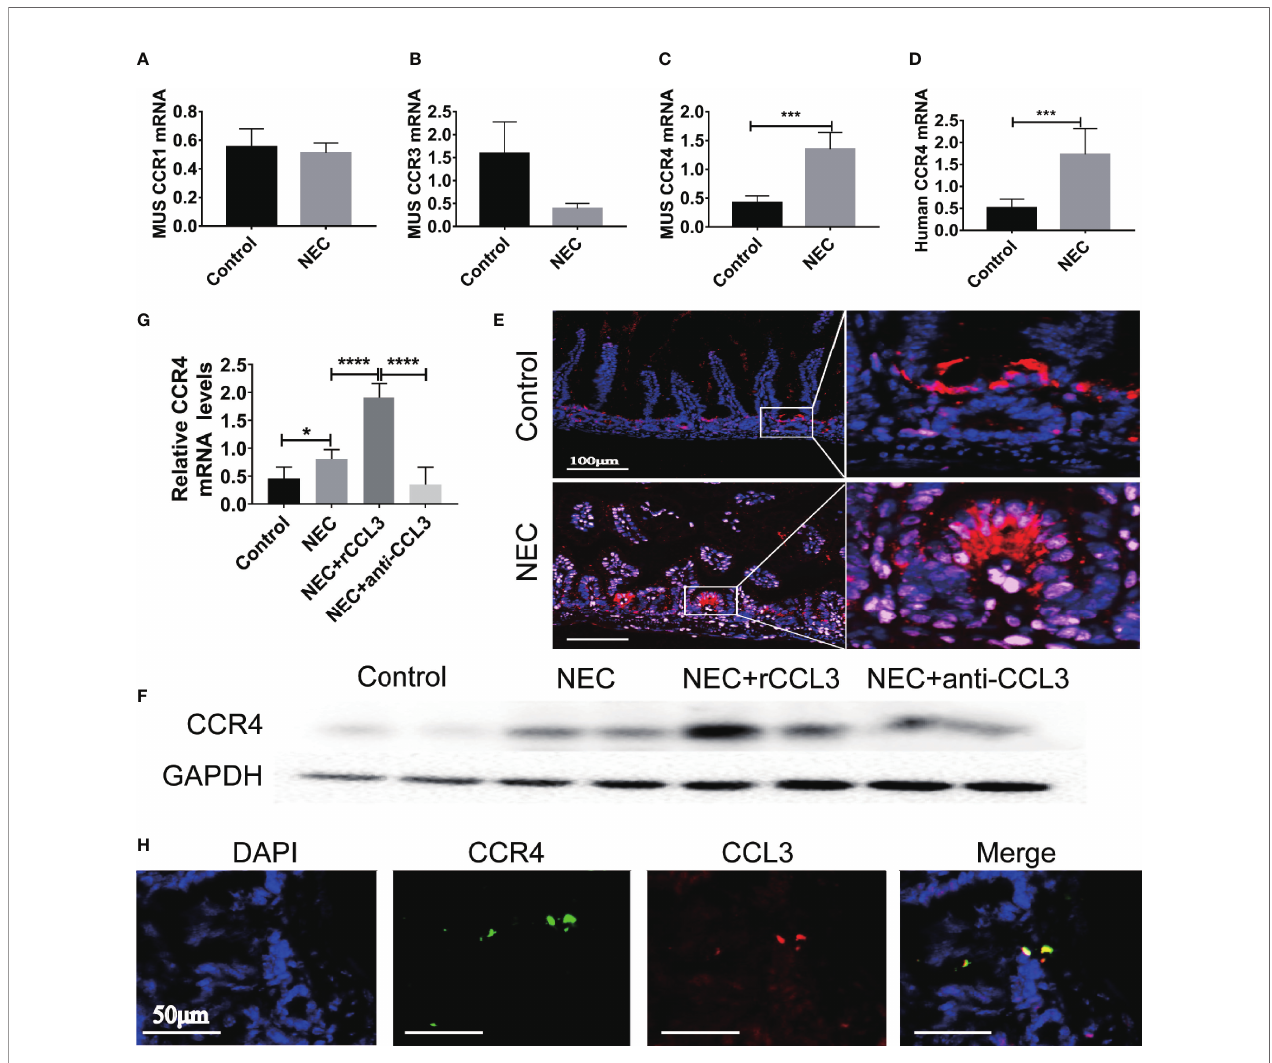
FIGURE 4 | CCL3 mediates intestinal injury by binding to CCR4 during NEC. (A-C) The mRNA expression of CCR1, CCR3, CCR4 in mice with NEC were determined by RT-PCR (n =4-6/group). ***p < 0.001 when compared with control group. (MannWhitney U test) (D) CCR4 mRNA expression in patients with NEC were detected by RT-PCR (n =4-6/group). ***p < 0.001 when compared with control group. (MannWhitney U test) (E) Representative Fluorescence micrographs from sections of the terminal ileum in mouse with or without NEC, immunostained for CCR4 (CY5-Tyramide conjugated anti-CCR4) as indicated (Scale bar=100 m m). (F, G) CCR4 in intestinal was determined by WB and the intensity was analyzed, compared with control, NEC, NEC+rCCL3 and NEC+anti- CCL3 groups. *p < 0.05, ****p < 0.0001 when compared between groups. (Mann-Whitney U test) (H) Immuno fl uorescence co-location assay was performed, incubation with anti-CCL3 (CY3-Tyramide), anti-CCR4(FITC), anti-E-Cad (a calcium-dependent transmembrane protein distributed in various epithelial cells) and DAPI as indicated (Scale bars: 50 m